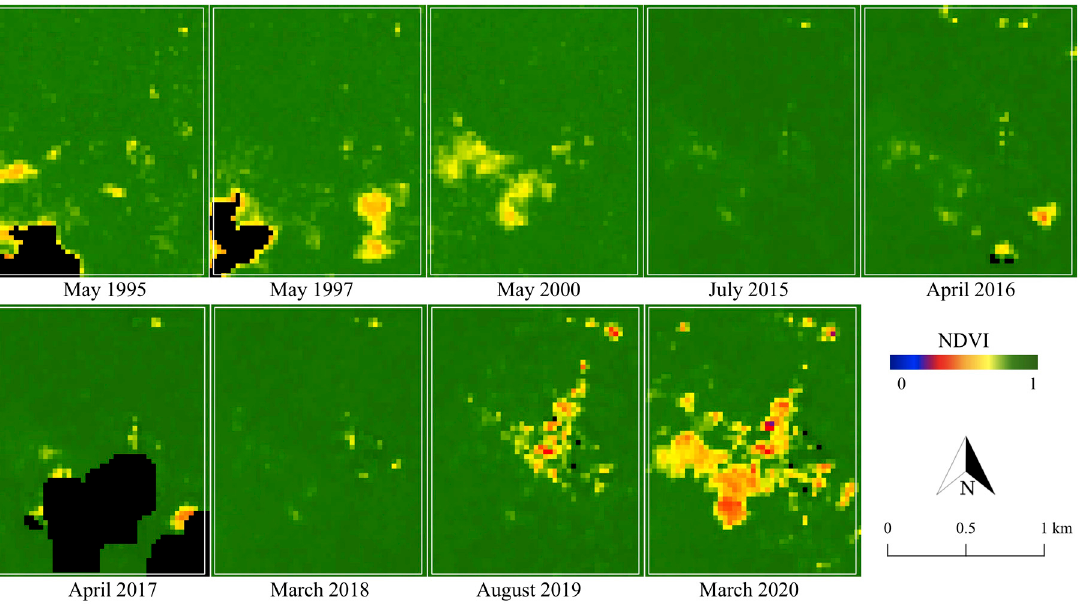
Figure 5. Changes in NDVI in Motomboto ASGM camp